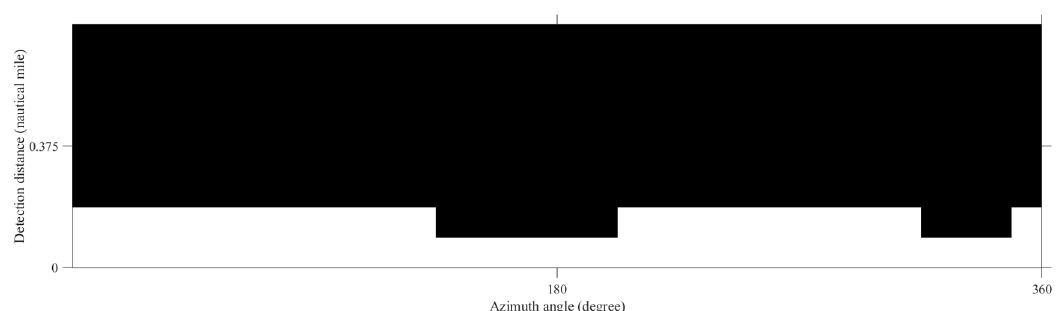
Figure 8. The result of BP neural network training.